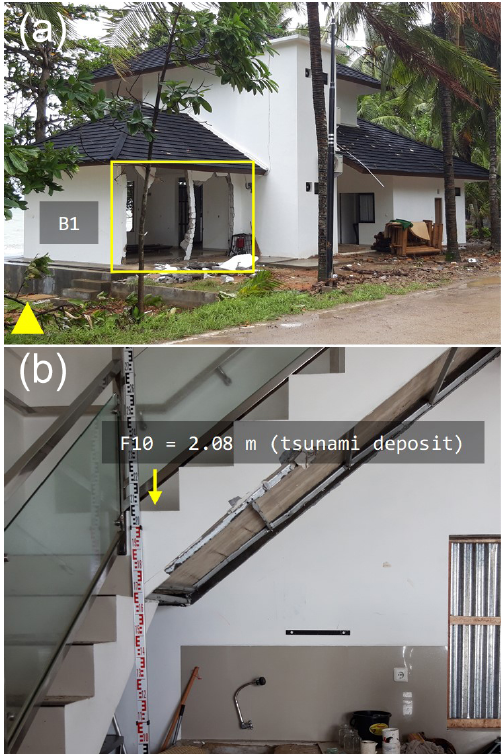
Figure 4. A villa’s wall destroyed by tsunami on Bulakan Pondok beach (a) and a 2.08m of flow depth recorded on the stair inside the villa (b) . One-storey house had a major damage; meanwhile the two-storey house was